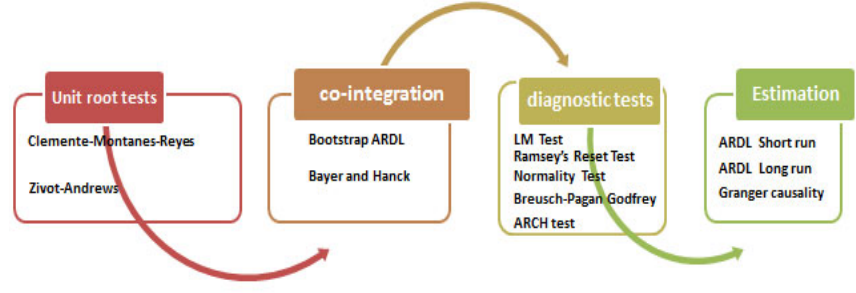
Figure 2. Structure of the